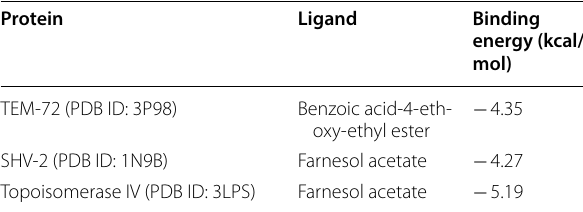
energy (kcal/ mol)